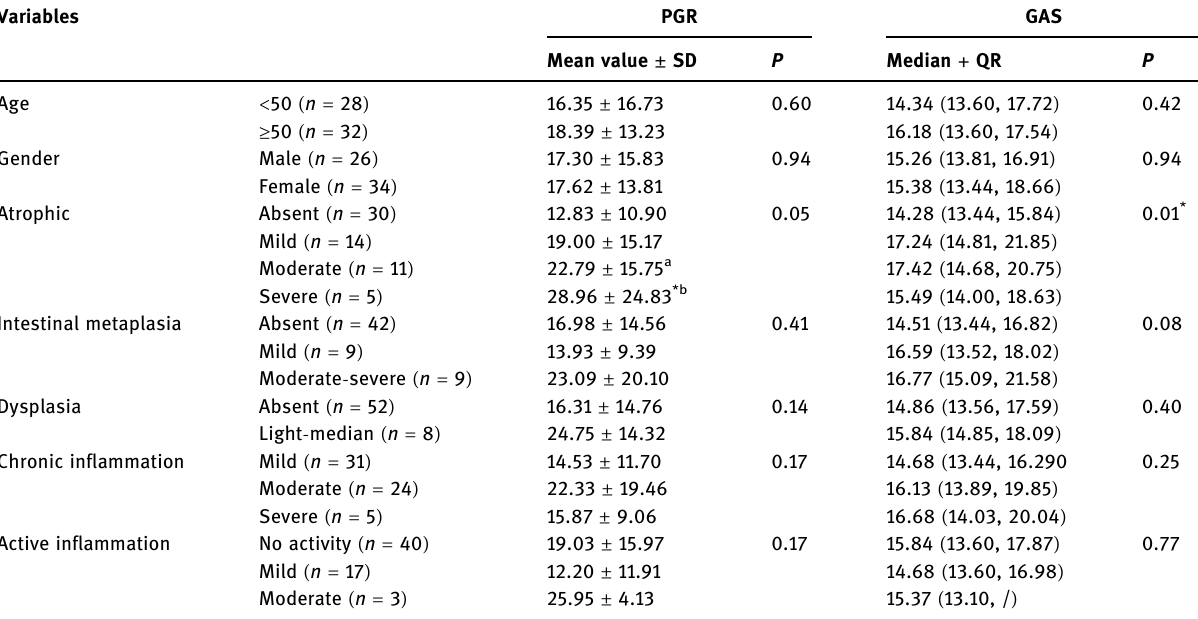
Table 1: Relationships between serum exosomal PGR, GAS, and clinicopathologic factors